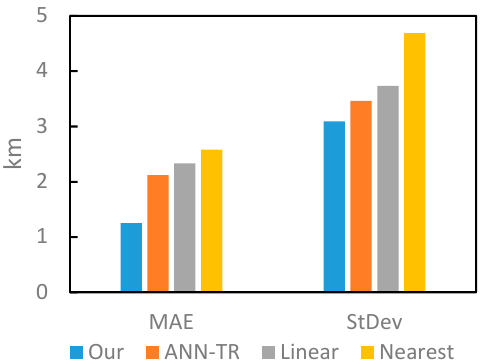
Figure 9. Comparison of the proposed method with baseline approaches using the indicators of mean absolute error (MAE) and StDev.